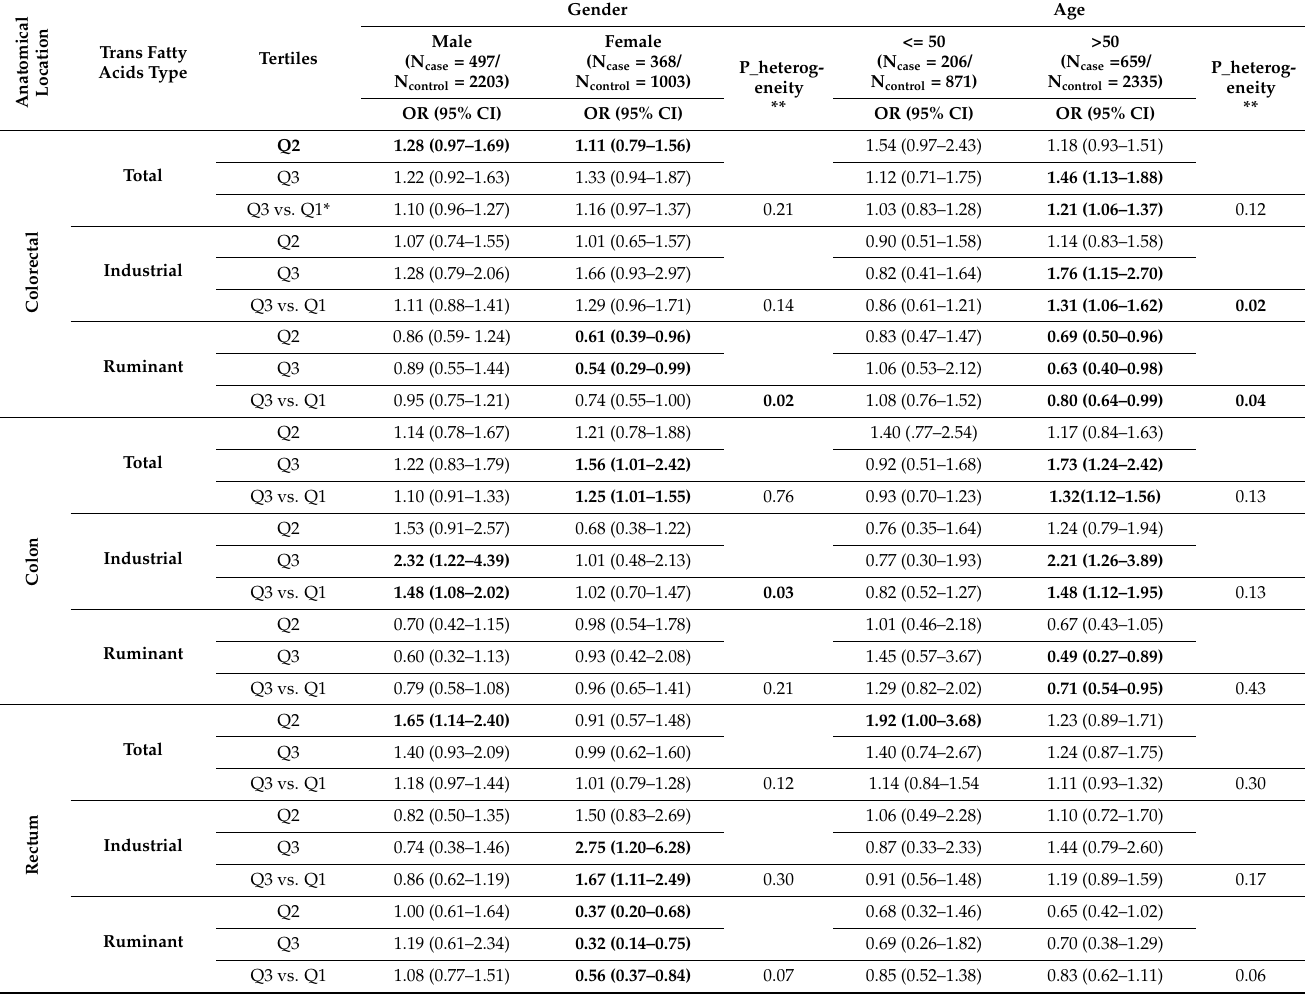
Table 3. The multivariable odds ratios (OR) and 95% confidence intervals (CI) of colorectal cancer and its subsites according to tertiles of trans fatty acids intakes, stratified by gender and age. Q1: